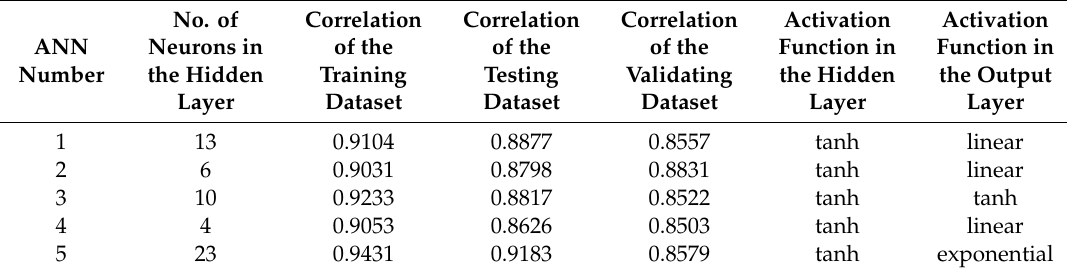
Table 4. The best predicting ANN found.